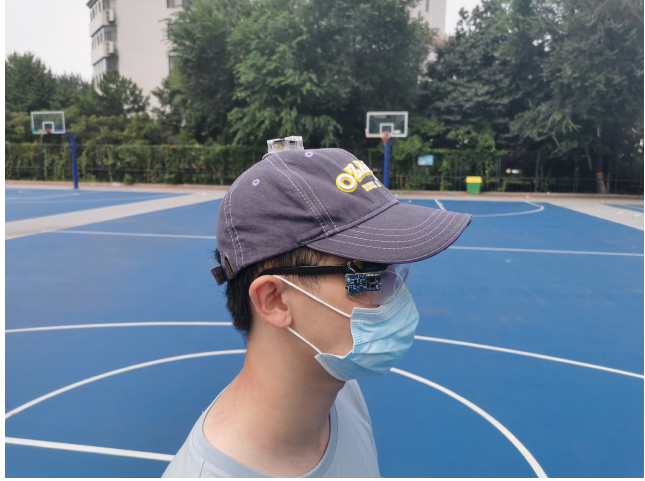
Figure 3. A subject wearing the